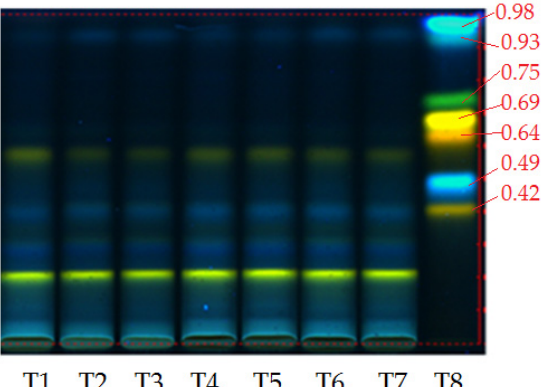
Figure 3. Polyphenols profile in the aqueous extracts from Plantago lanceolata L. Folium. Track T1,